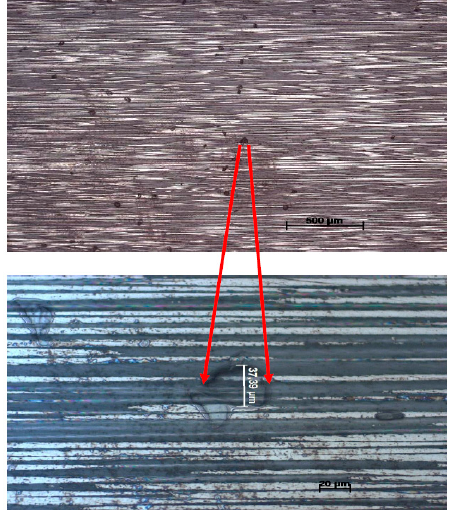
Figure 16. Cross-sectional microstructure of the CFRP highlighting the presence of process induced porosity.